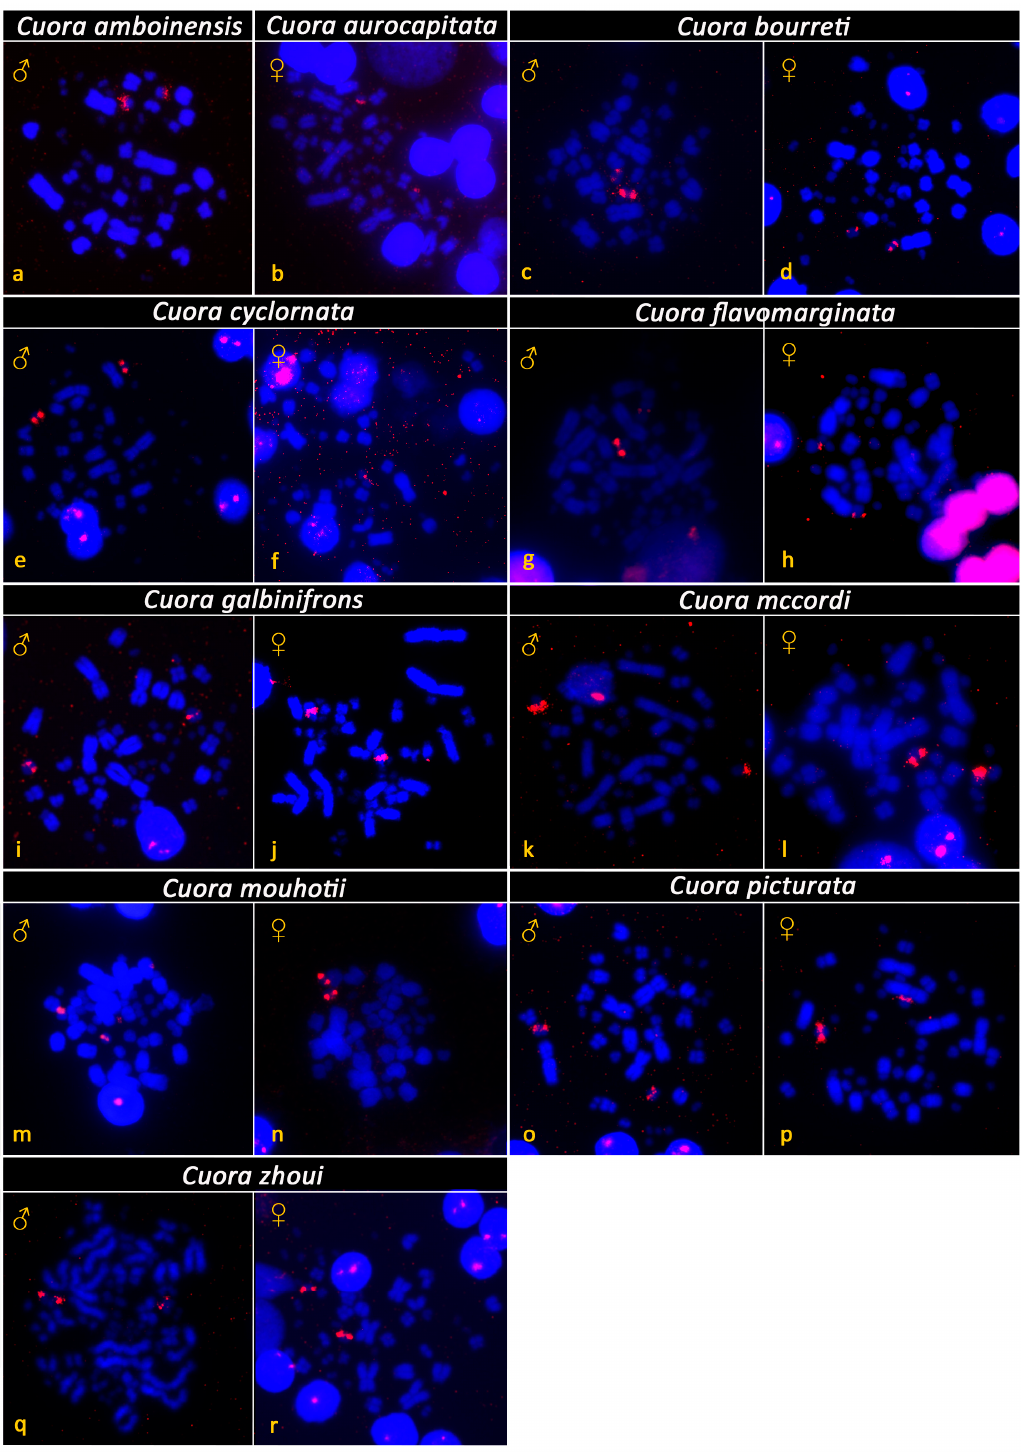
Figure 3. Distribution of rDNA loci (red color) on DAPI-stained metaphases (blue color) from Cuora amboinensis ( a ), Cuora aurocapitata ( b ), Cuora bourreti ( c , d ), Cuora cyclornata ( e , f ), Cuora flavomarginata ( g , h ), Cuora galbinifrons ( i , j ), Cuora mccordi ( k , l ), Cuora mouhotii ( m , n ), Cuora picturata ( o , p ), and Cuora zhoui ( q , r ). rDNA loci accumulate in the 9th chromosomal pair, in all examined species.